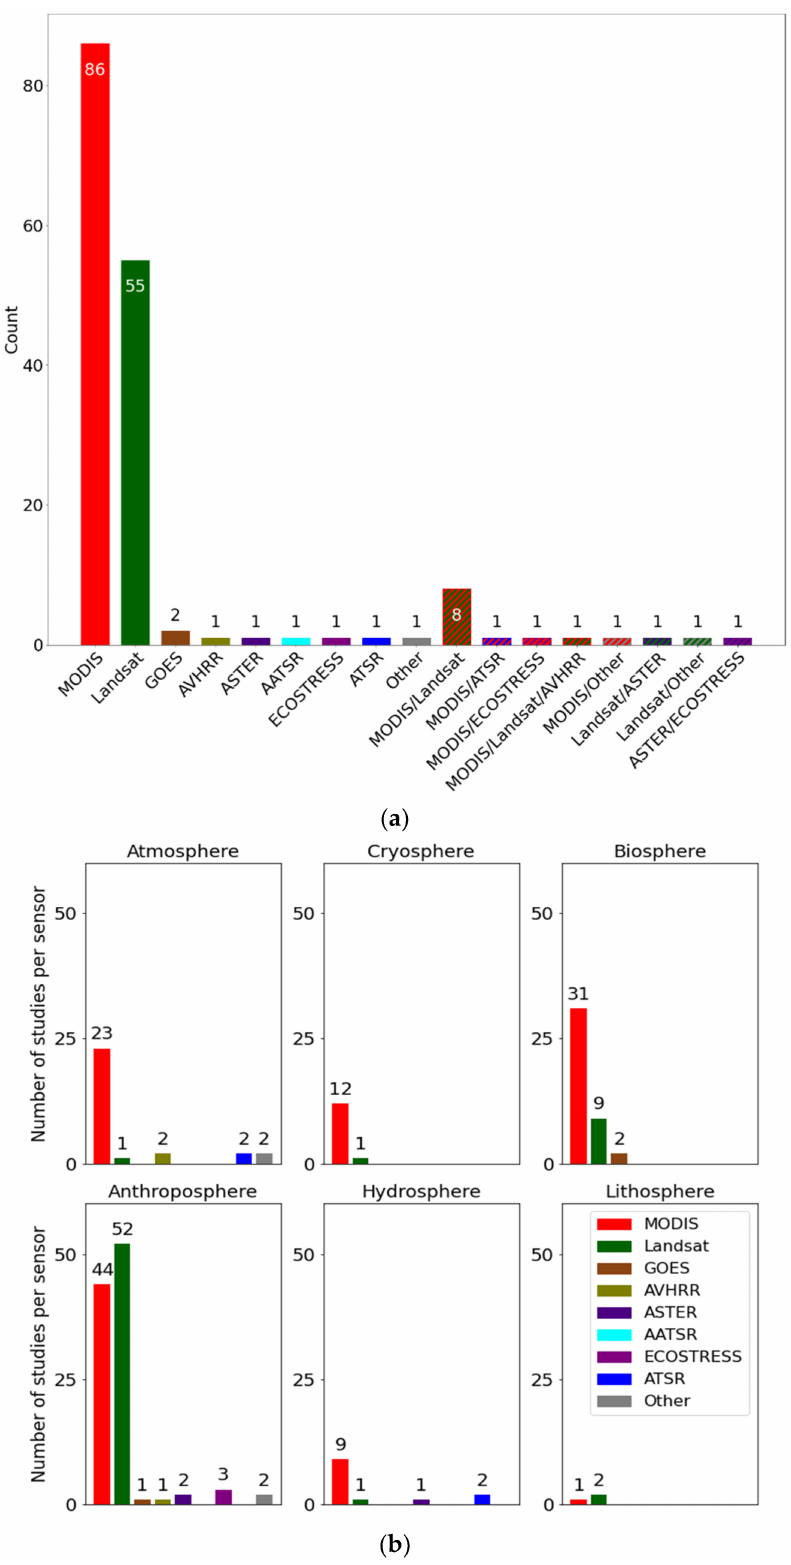
Figure 7. Number of reviewed studies per sensor system or sensor system combination ( a ) and number of studies per sensor system in each research sphere ( b ) (studies with sensor combinations or multiple research topics were counted several times for this